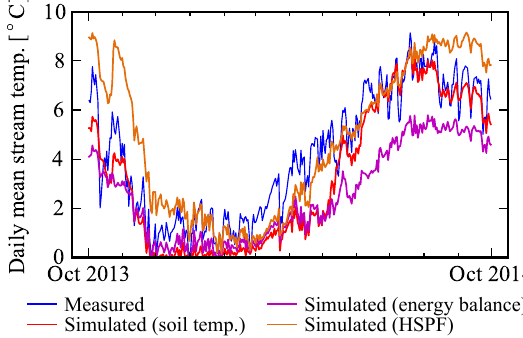
Measured Simulated (soil temp.) Figure 10. Comparison between various predictions of stream tem- perature at the catchment outlet, where the temperature of the sub- surface water flux is computed based on the following methods: the original scheme implemented in StreamFlow (energy balance), the technique of the Hydrological Simulation Program–Fortran (HSPF), or as soil temperature averaged over a depth of 2 . 40m (soil temp.). All curves are aggregated into daily mean values for visibil-